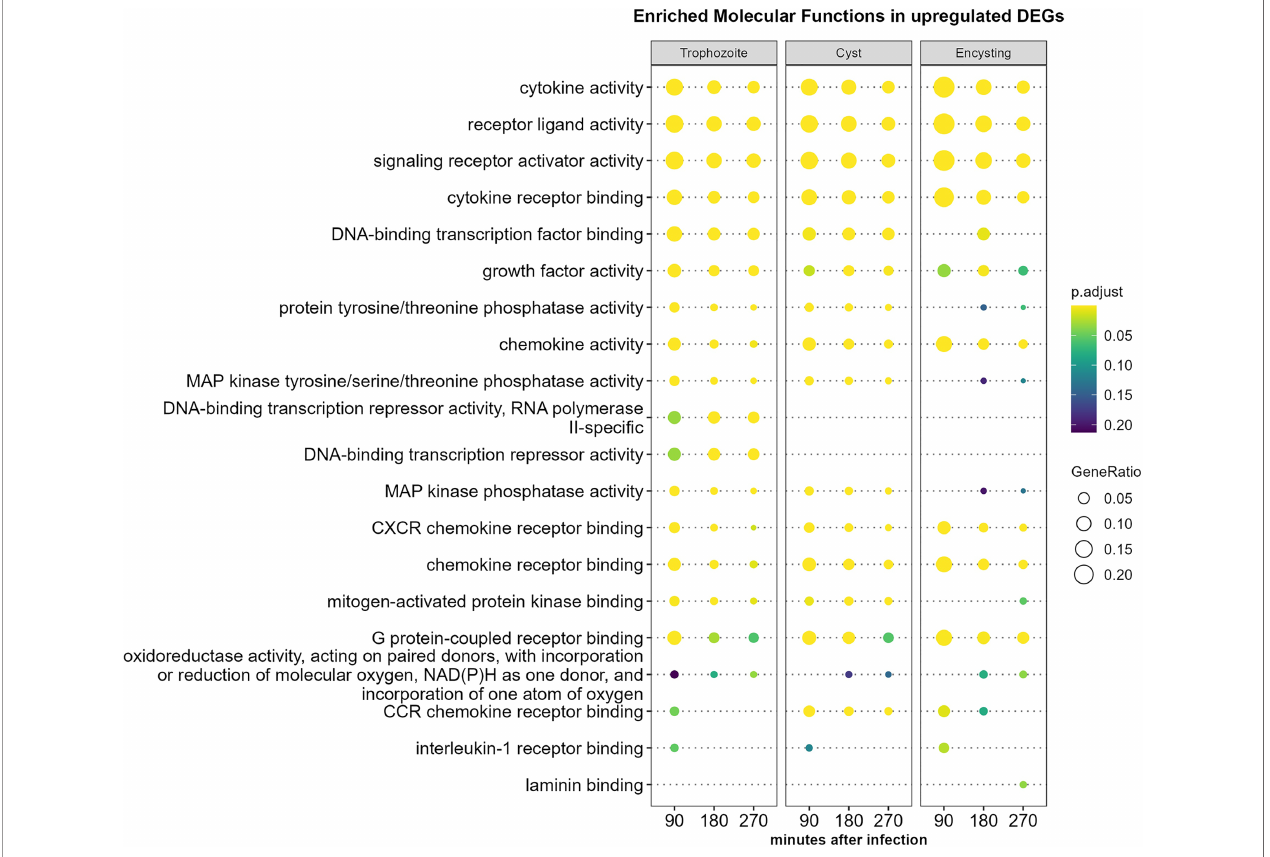
FIGURE 2 | Molecular function enrichment analysis of up-regulated human genes (more than two-fold) during Giardia infections of differentiated Caco-2 cells. Comparison of the top 10 gene ontology (GO) terms in molecular function in each of the different Giardia stage infections (trophozoite, cyst and encysting cells Caco- 2 infections) and infection timepoints (1.5, 3, and 4.5 h post-infection). Circle size and color indicate the gene ratio (number of differentially expressed genes against the number of genes associated with a GO term) and their signi fi cance, respectively. GO, gene ontology; MF, molecular